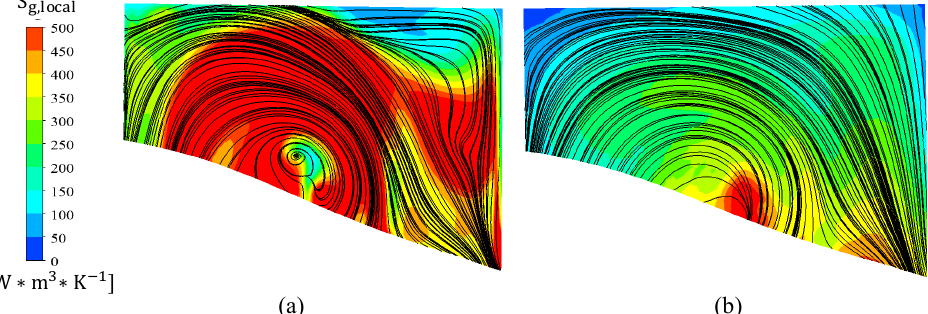
Figure 10. Backward streamlines and entropy contours of the slot near the stall condition. ( a ) SES; ( b ) CCT.